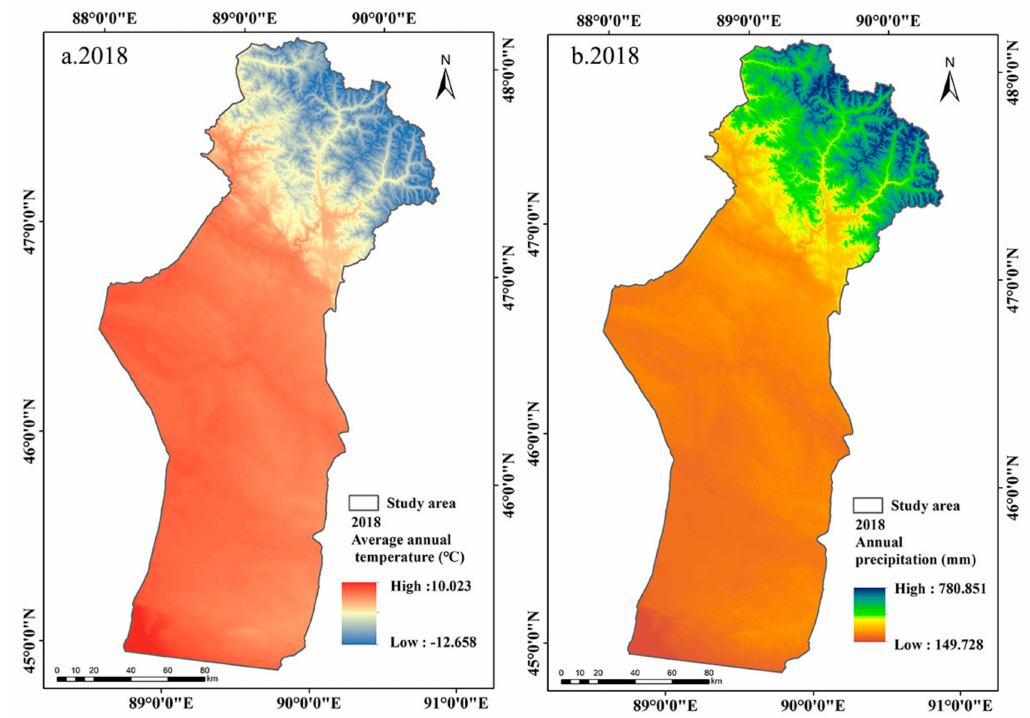
Figure 10. Spatial distribution of average temperature and annual precipitation in